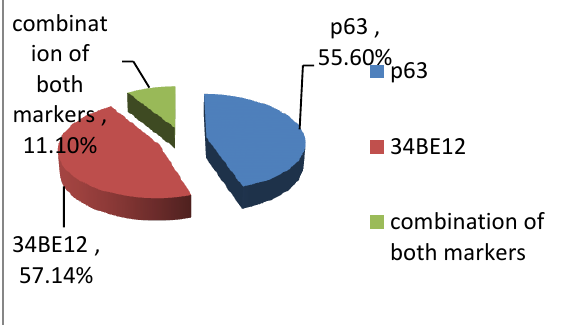
Fig(3). false negative benign glands(>2) lack basal cells staining for each marker (34BE12 , and p63) and in combination of both markers in BPH